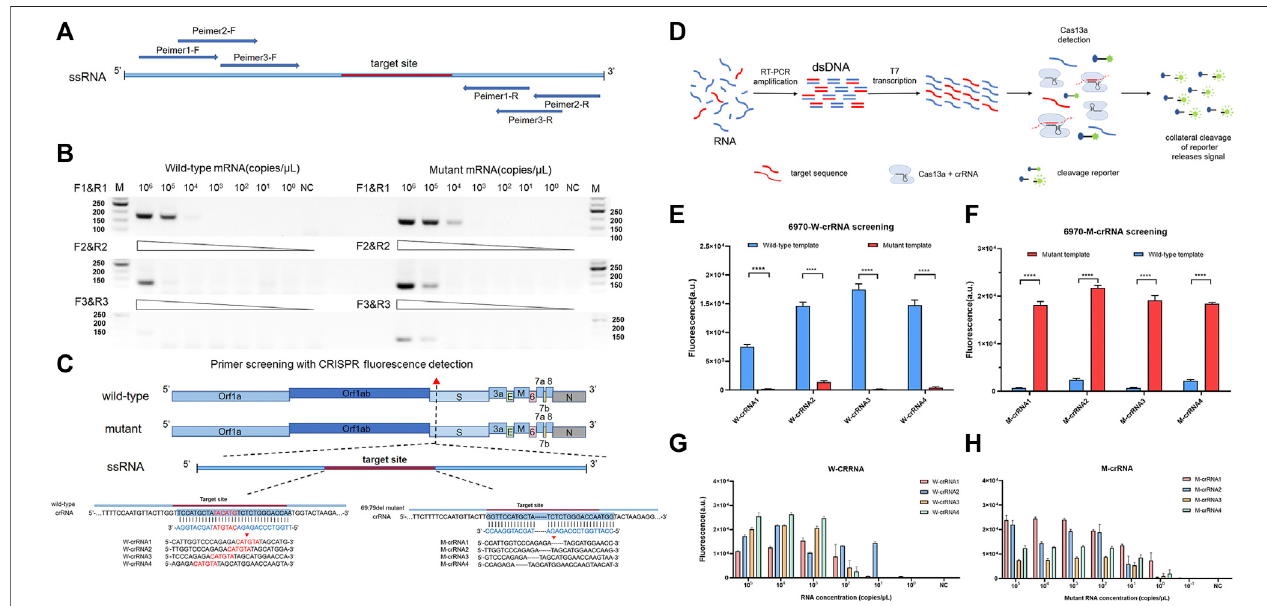
FIGURE 1 | Identifying the sensitivity and speci fi city of different crRNA and primer sets with RT-PCR followed by Cas13a detection. (A) Schematic of the primer design. (B) Agarose gel electrophoresis con fi rms the ampli fi cation ef fi ciency of RT-PCR 69-70 primers. (C) Schematic of SARS-CoV-2 mutant target regions and the crRNA sequences usedfordetection.Thetarget site isblue, and themutant siteisred. (D) Schematic ofRT-PCR +CRISPR detection. (E) Highlyspeci fi citydetectionof wild-typeandmutanttemplateforthedifferentiationofSARS-CoV-2wild-typecrRNAtargetsusingCas13a. (F) Highlyspeci fi citydetectionofwild-typeandmutant template for the differentiation of SARS-CoV-2 mutant crRNA targets using Cas13a. (G) Sensitivity detection of four different wild-type crRNAs carried out using PCR- CRISPR and wild-type templates. (H) Sensitivity detection of four different mutant crRNAs carried out using PCR-CRISPR and mutant templates. ( n = 3 technical replicates, two-tailed Student t-test; **, p < 0.01; ****, p < 0.0001; ns, no signi fi cant difference; bars represent mean ±